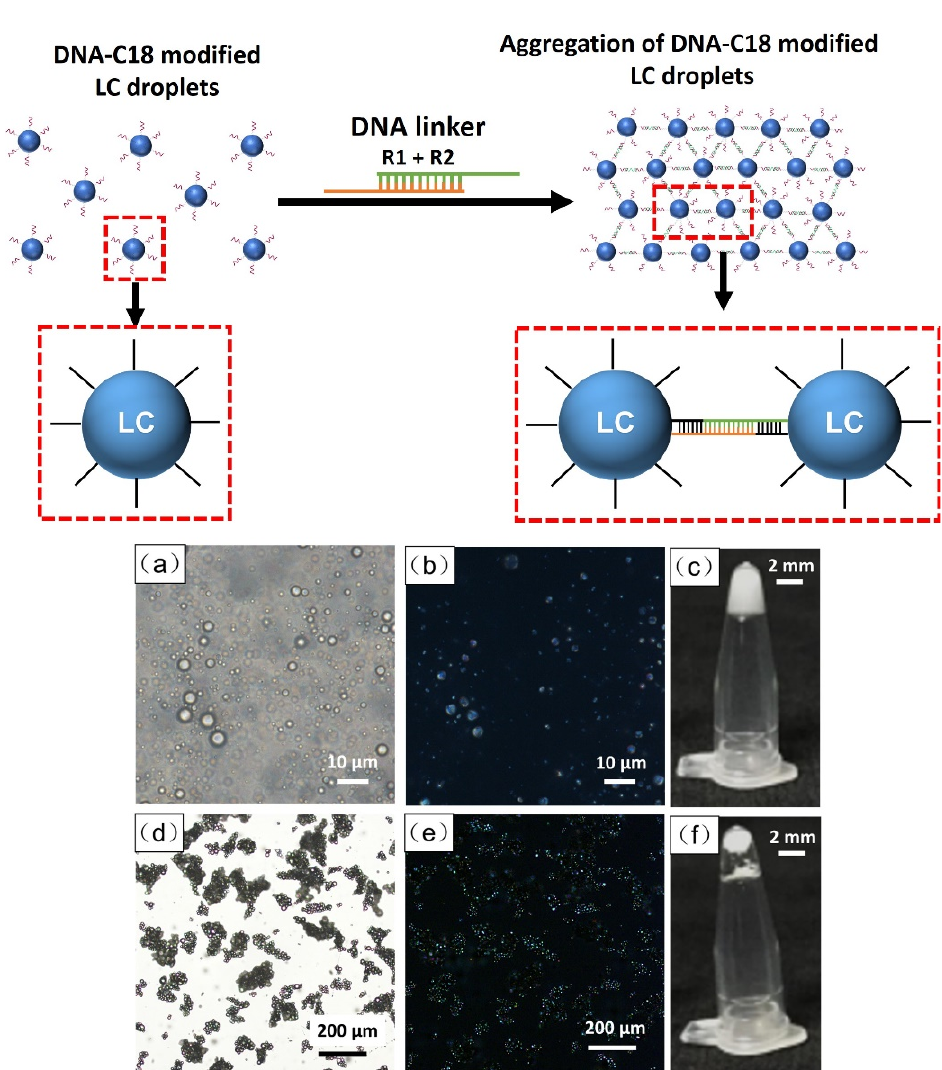
Figure 2. Schematic diagram of DNA ‐ modified LC droplets and aggregated DNA ‐ modified LC droplets in presence of DNA linker R1 + R2. Microscope images of DNA ‐ modified LC droplets be ‐ fore ( a – c ) and after ( d – f ) adding DNA linker; ( a , d ) bright field, ( b , e ) polarized light, ( c , f ) photograph of macroscopic emulsion.